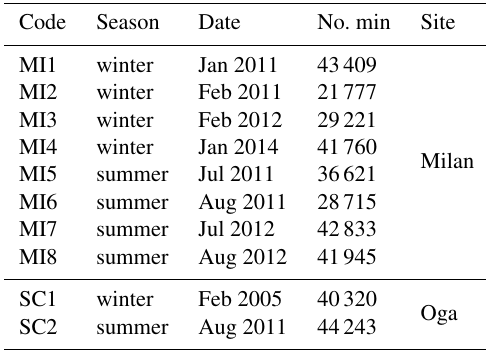
Table 1. List of sites with indication of season, date of measurement and number of